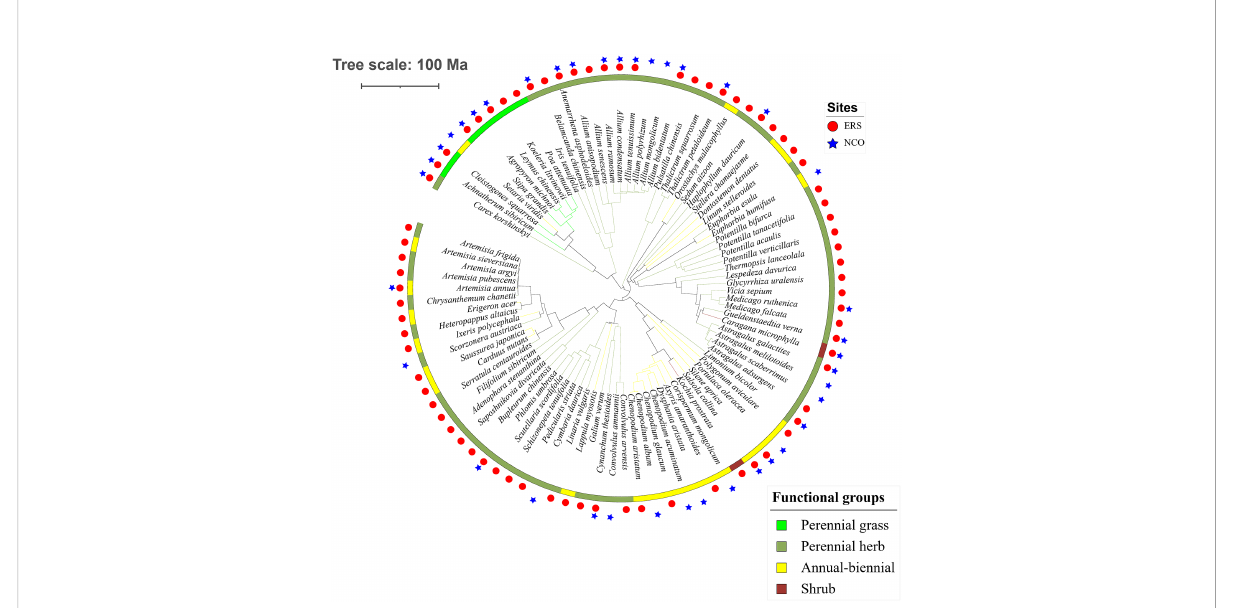
FIGURE 2 Phylogenetic tree of the 89 species observed in this study. Circles and stars represent species recorded at Inner Mongolia Grassland Ecosystem Research Station (ERS) and Xilinhot National Climate Observatory (NCO) in Inner Mongolia, China,